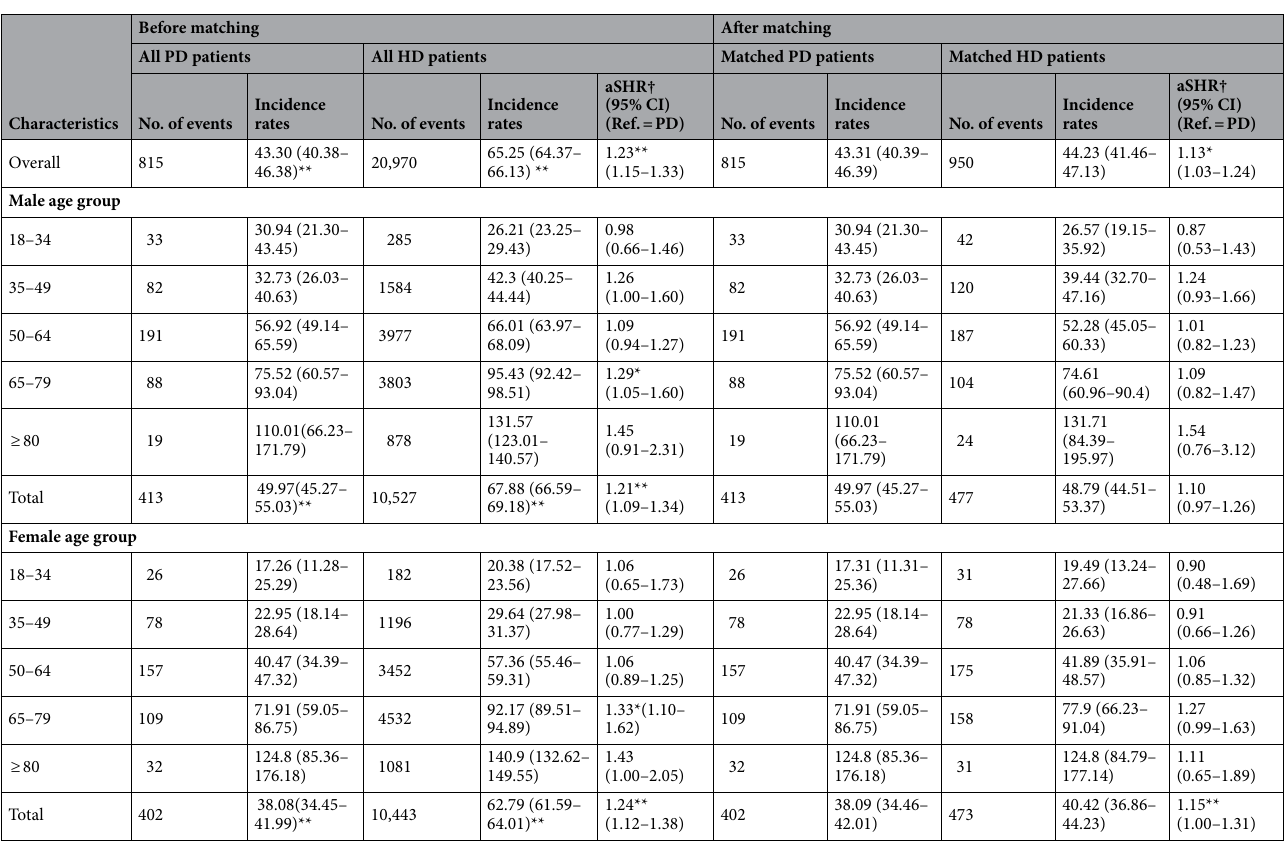
Table 2. Comparison of incidence rates (per 1000 patient-years) and relative risk of gastrointestinal bleeding between patients with hemodialysis (HD) and peritoneal dialysis (PD) before and after matching using propensity scores. The comparisons of overall and sex-specific incidence rates and cumulative incidence rates between the HD and PD patients without matching were all statistically significant ( p < 0.0001), and the male and female incidence rates for the HD and PD patients with matching were statistically significant ( p < 0.05). aSHR Adjusted subdistribution hazard ratio; Ref. Reference group; CI Confidence interval. † Based on a Cox proportional hazard regression with a competing risk analysis and adjusted for age, sex, selected comorbidities (diabetes mellitus, hypertension, coronary artery disease, peripheral vascular disease, heart failure, stroke, chronic obstructive pulmonary disease, hyperlipidemia, rheumatological disease) and medications (Aspirin, Antiplatelet agent, NSAID, Cox-2 selective inhibitors, Corticosteroids, Selective Serotonin Reuptake Inhibitors, Anticoagulants, Gastroprotective agents, Aldosterone antagonists, Calcium channel blocker, Nitrates). * p value < 0.05. ** p value <